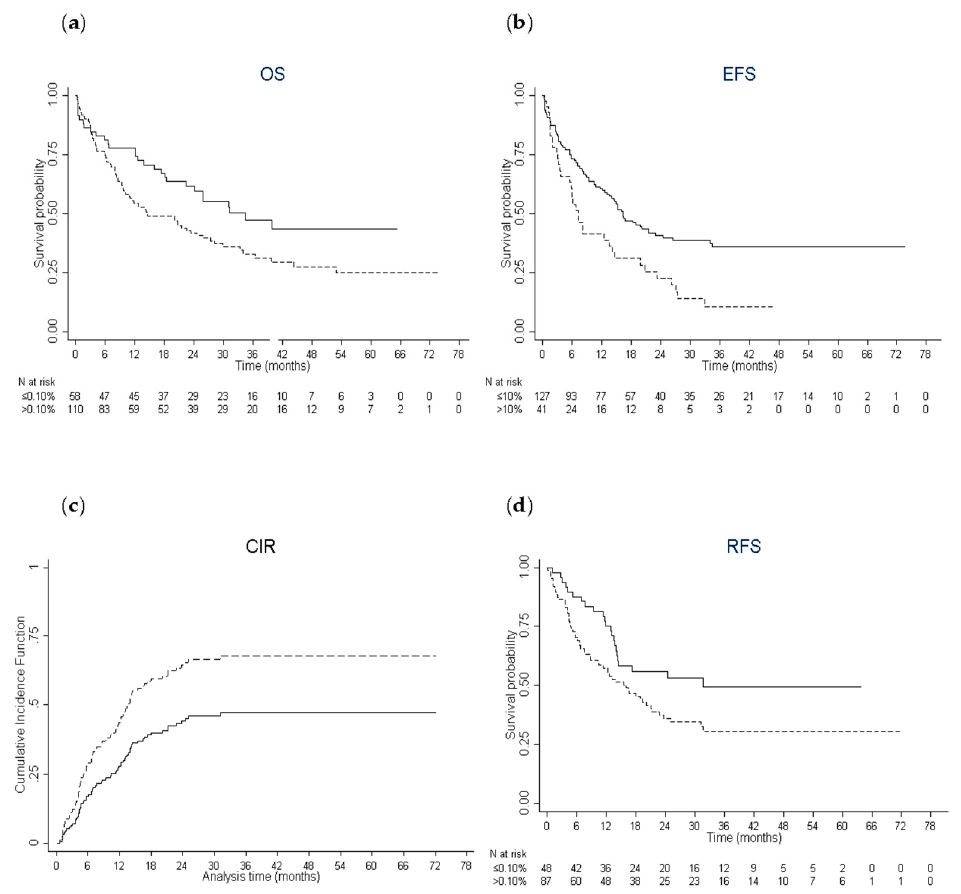
Figure 1. Estimates of survival end points and incidence of relapse. ( a ) Kaplan–Meier curves for overall survival according to the leukemic stem frequency (CD34 + CD38 − CD123 + % ≤ 0.10%: solid line; > 0.10%: dashed line) in patients treated by intensive chemotherapy. ( b ) Kaplan–Meier curves for event-free survival (CD34 + CD38 − CD123 + % ≤ 10%: solid line; > 10%: dashed line). ( c ) Cumulative incidence of relapse (CD34 + CD38 − CD123 + % ≤ 10%: solid line; > 10%: dashed line). ( d ) Kaplan–Meier curves for relapse-free survival (CD34 + CD38 − CD123 + % ≤ 0.10%: solid line; > 0.10%: dashed line).